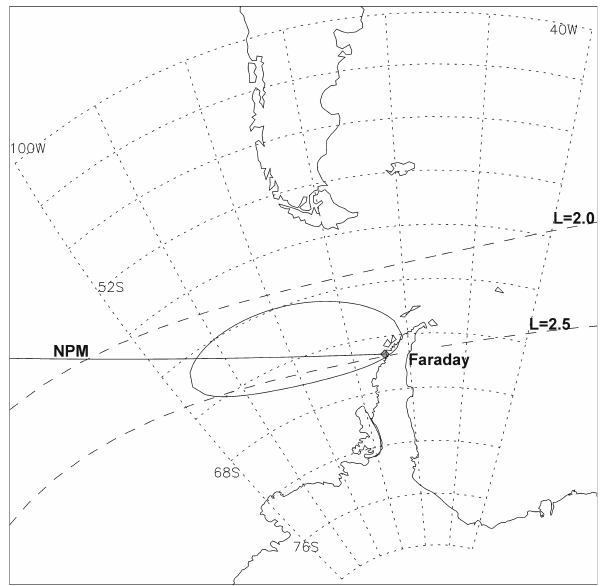
Fig. 1. Map of the region around the Antarctic Peninsula, showing the location of Faraday Station. The Great Circle Path to the trans- mitter NPM is plotted, along with the L = 2 . 0 and L = 2 . 5 contours at 100km altitude. An ellipse marks the WEP modified ionospheric region used in our calculations.